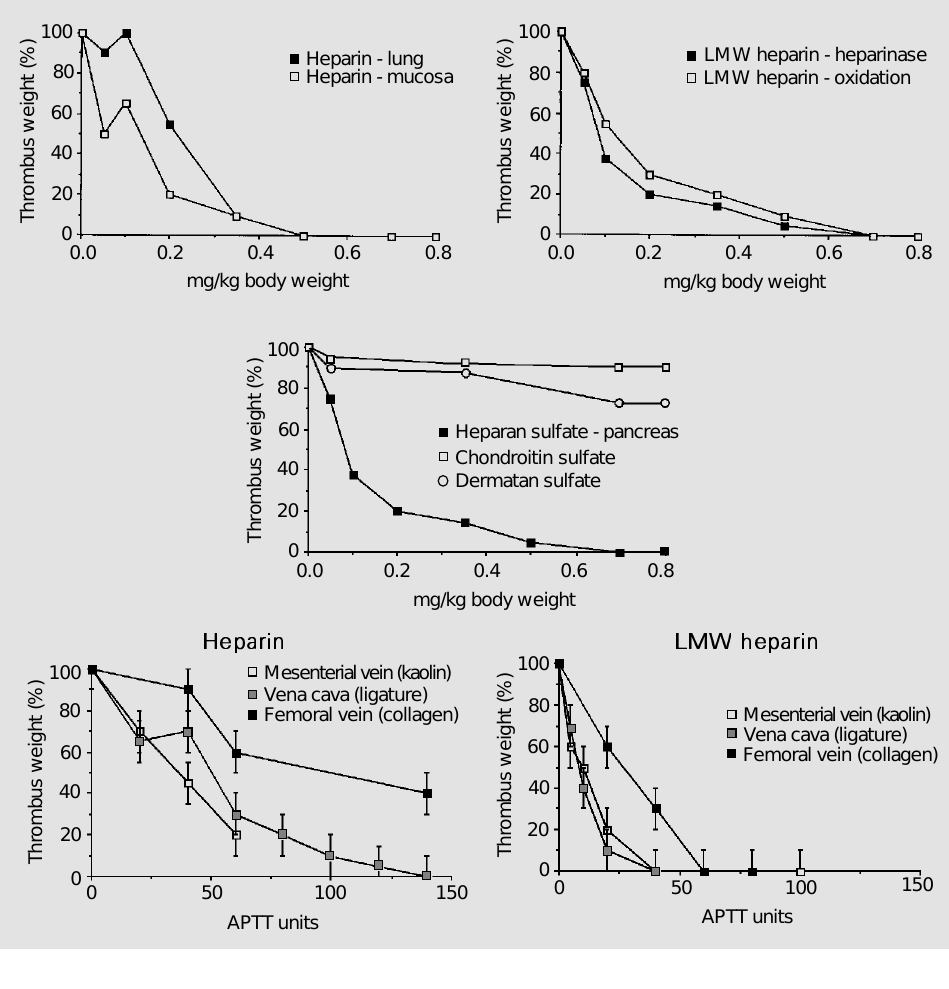
Figure 6. In vivo antithrombotic activities of heparin, low molec- ular weight (LMW) heparins, heparan sulfate and other gly- cosaminoglycans in different venous models. APTT, activated partial thromboplastin time.